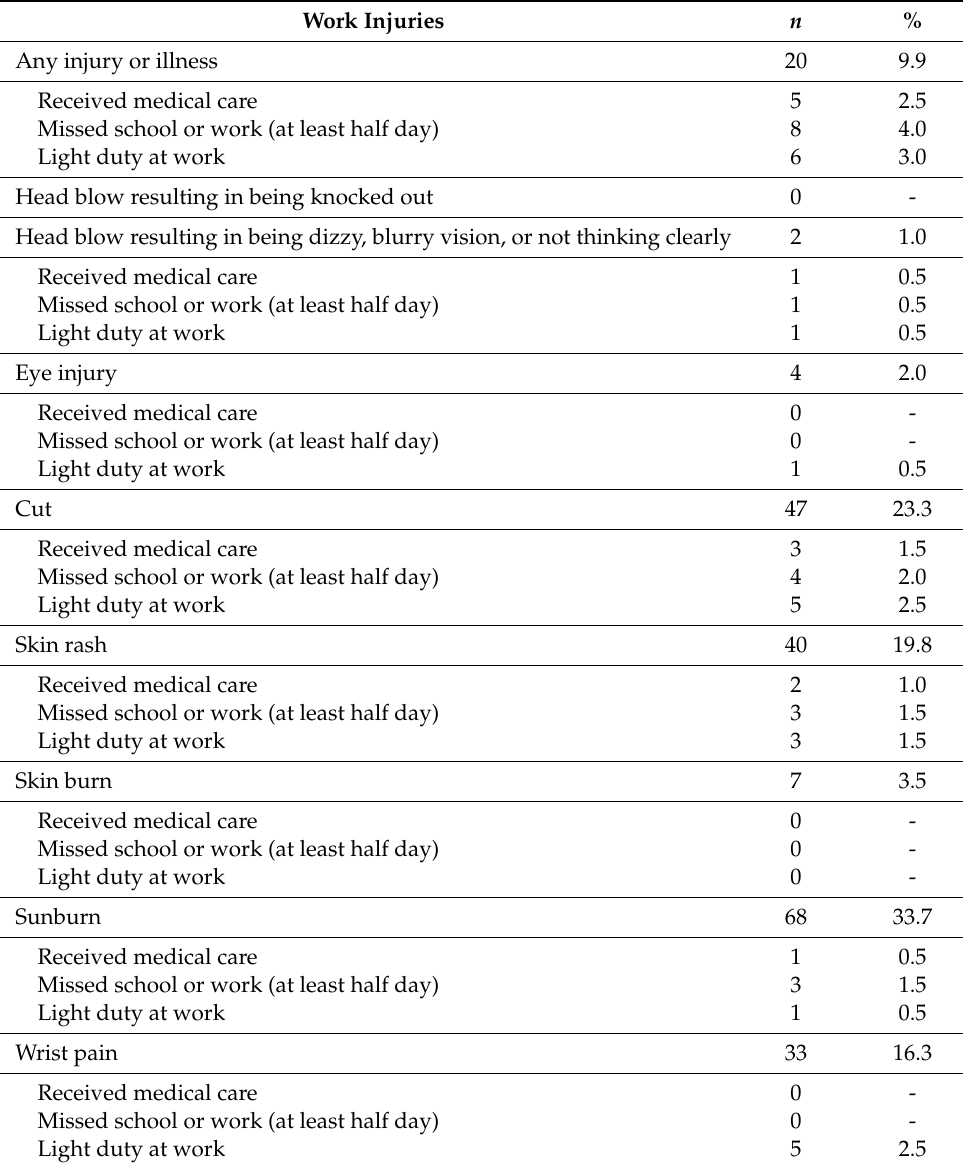
Table 5. Farm work injuries in the past 12 months, Latinx child farmworkers in North Carolina, 2017 (N =